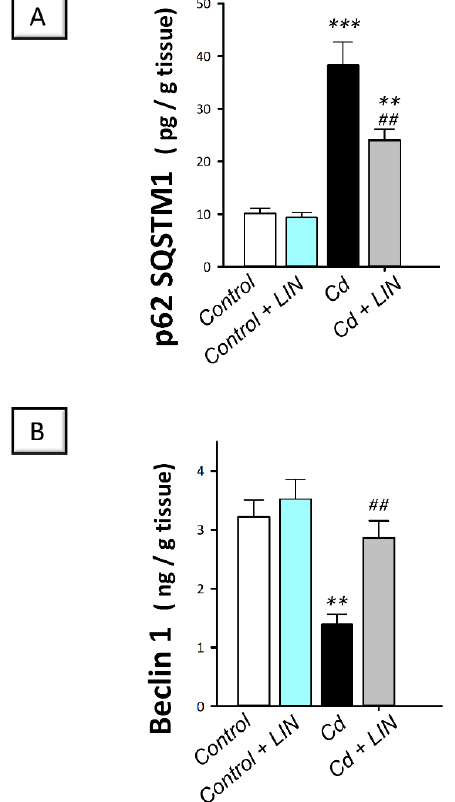
Figure 9. Effect of cadmium and/or linagliptin administration on testicular autophagy in rats. The co-treatment with linagliptin enhanced the testicular autophagy response that was compromised by cadmium metal. This was demonstrated by diminished protein expression of the negative autophagy marker protein 62 sequestome 1 (p62 SQSTM1; ( A )) alongside increased protein expression of the positive autophagy marker Beclin 1 ( B ). ** p < 0.01, and *** p < 0.001 show statistical significance compared to the group of control rats; ## p < 0.01 show statistical significance compared to the group of cadmium ‐ intoxicated rats. Values are stated as the mean ± standard error of the mean for 6 animals per group. LIN, linagliptin; Cd, cadmium chloride.